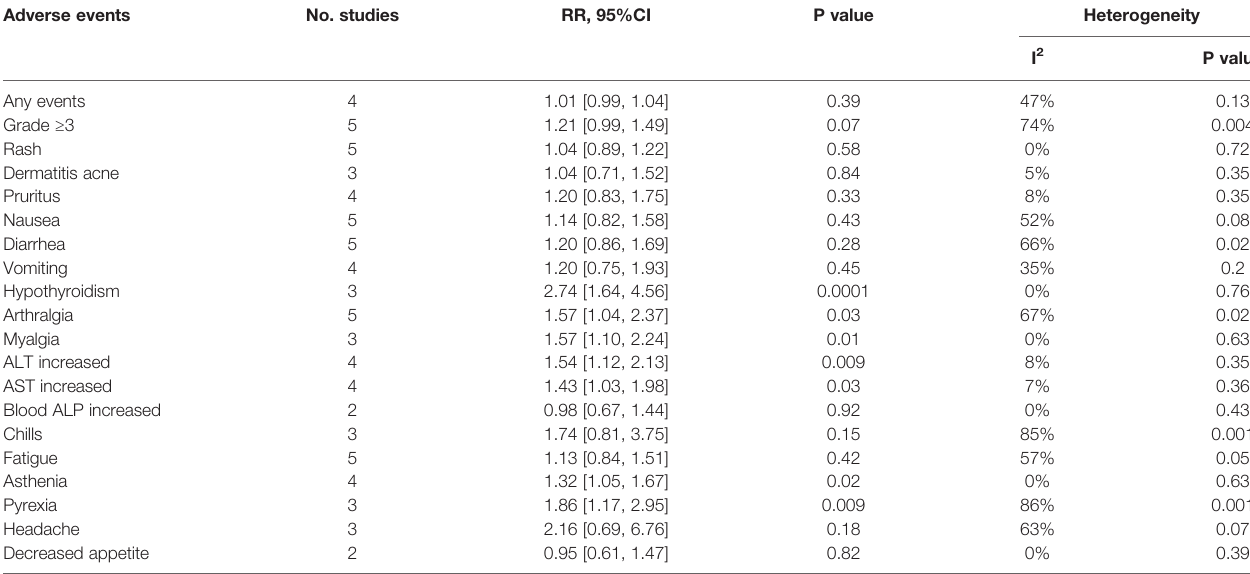
TABLE 2 | Outcomes of all-grade adverse events (AEs) and grade ≥ 3 adverse events for triple combination therapy versus control therapy. Adverse events